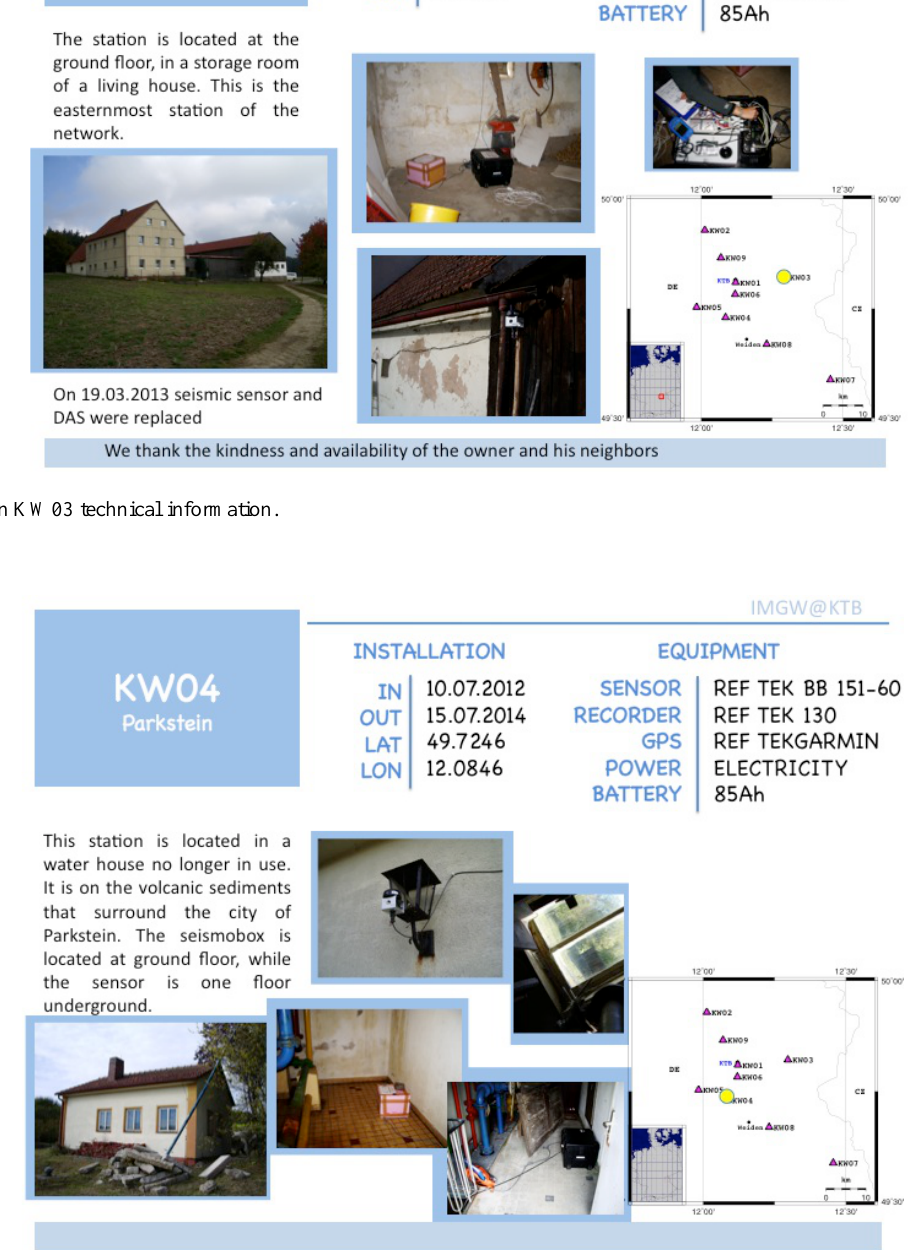
Figure A4. Station KW04 technical